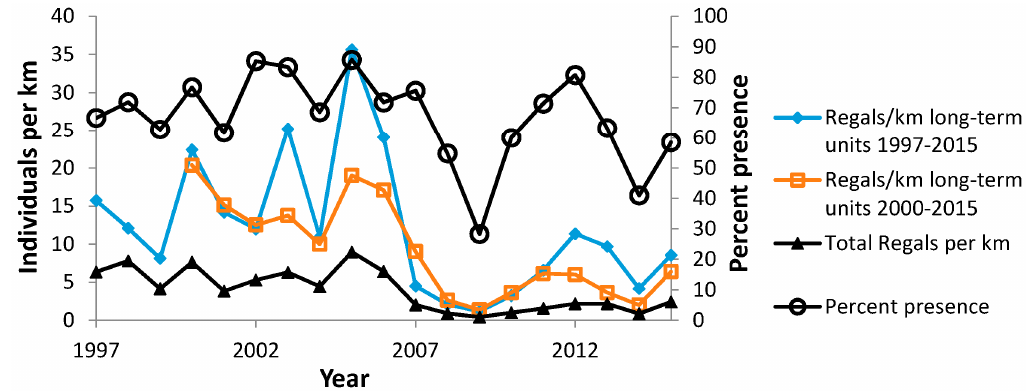
Figure 7. Regal fritillary incidence and abundance at Buena Vista Grassland: individuals per km on peak survey per year in units surveyed 1997–2015 and in the rest of the long-term units surveyed 2000–2015, and total individuals per total km surveyed each year (left axis), and percent presence in all units surveyed each year (right axis).